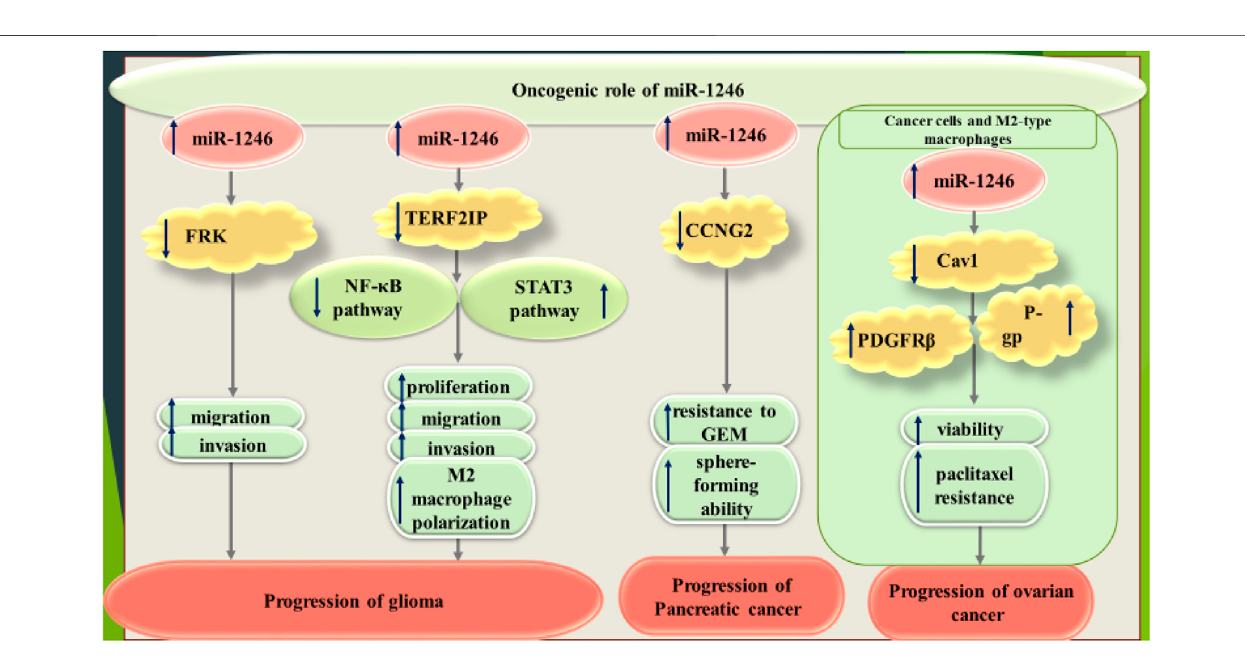
Frontiers in Molecular Biosciences |